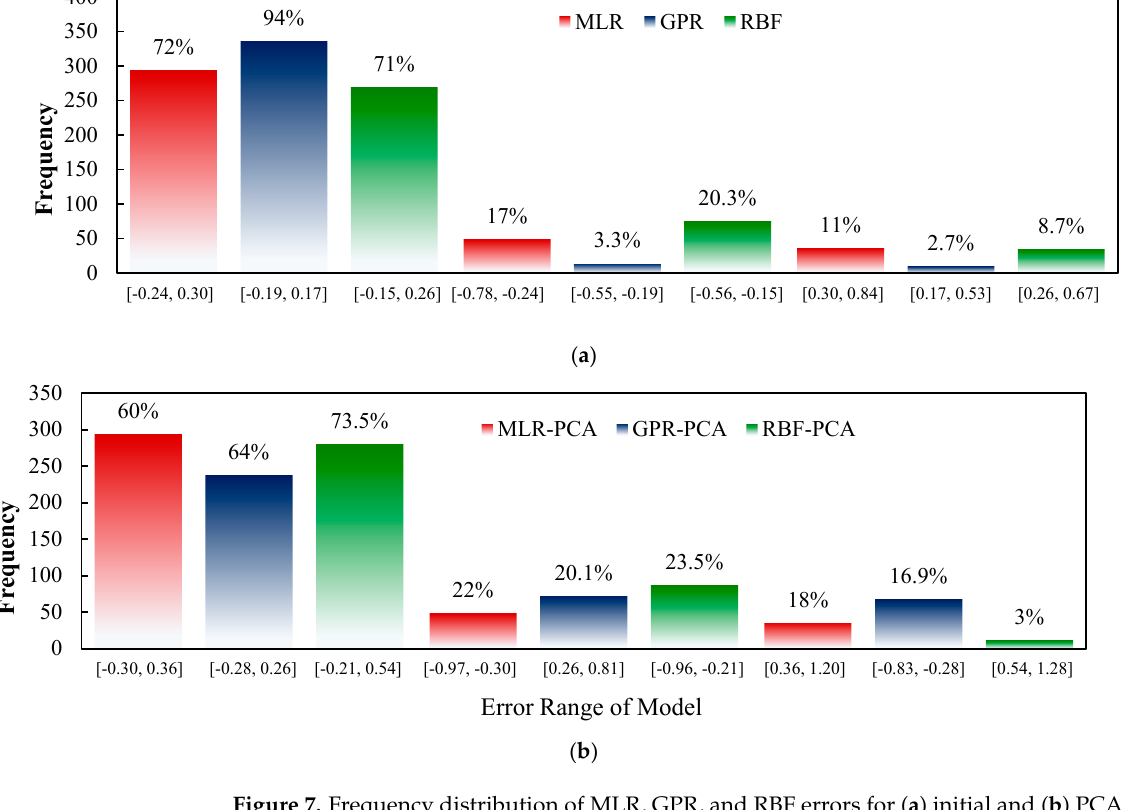
Figure 7. Frequency distribution of MLR, GPR, and RBF errors for ( a ) initial and ( b ) PCA independent variables.